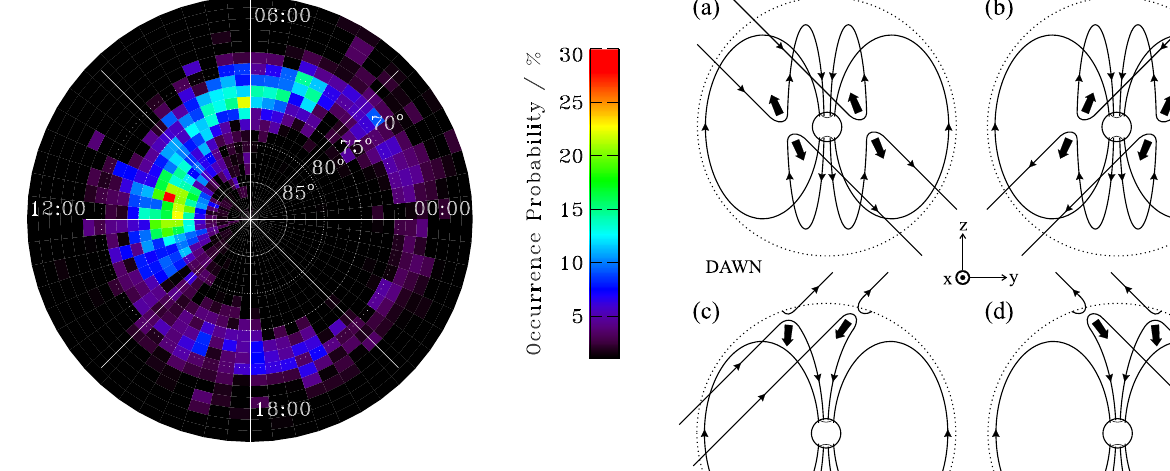
Fig. 1. The occurrence probability distribution of He 2 + ions in the magnetosphere plotted as invariant latitude ( 3 ) versus magnetic lo- cal time (MLT) in polar co-ordinates. In addition to the cusp near noon, an interesting feature in this plot is the peak in the occurrence probabilities along the dawn flank, 3 ∼ 72 ◦ . The plot is for 3 from 60 ◦ to 90 ◦ for all MLTs with a bin size of 1.5 ◦ by 24 min. The energy of He 2 + ions ranges from 1.8 to 21.4 keV and samples are for all orientations of the IMF. Each bin has a 15 sample thresh- old to ensure reliable statistics. CAMMICE MICS data used in this plot was taken almost continuously from 18 March 1996 to 13 April 1999.